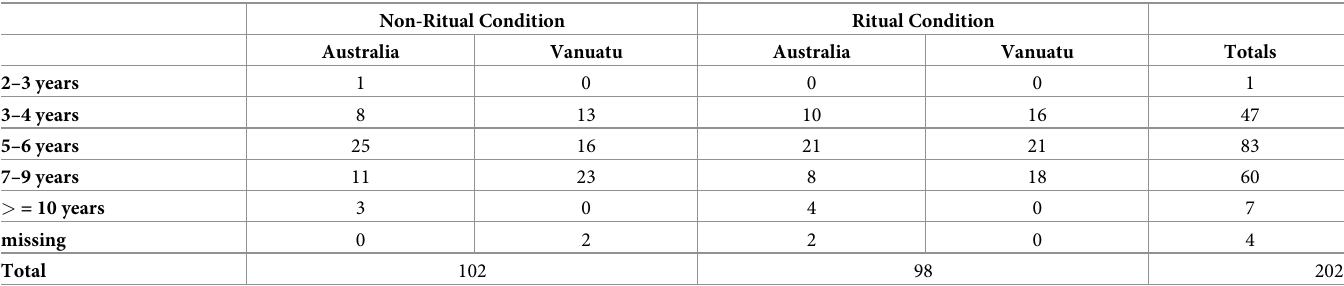
Table 2. The distribution of participants across conditions, and regions, as a function of age.